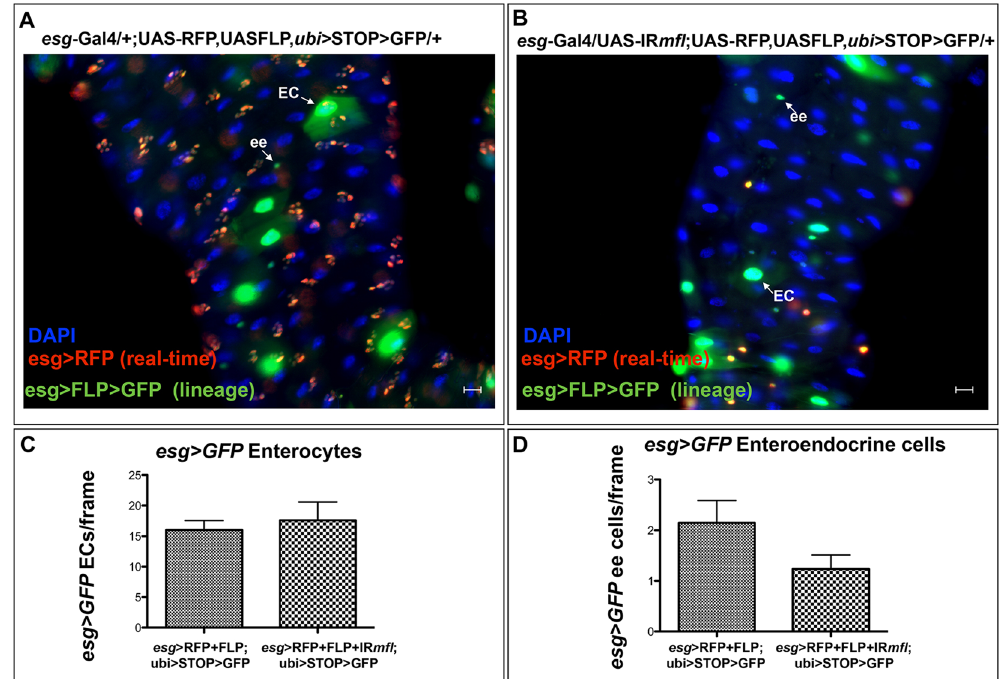
Figure 6. Lineage tracing analysis of midgut esg + cells. Control ( A ) and silenced ( B ) midguts were analyzed in epifluorescence at the third larval stage. DAPI is in blue; GFP in green; esg + cells are marked by RFP in red and appear as clustered into imaginal islands in ( A ) and as dispersed cells in ( B ); white arrows indicate differentiated ECs and ees deriving from esg + precursors. Scale bars: 20 µ m. Histograms reporting the number of GFP + ECs ( C ) and of GFP + ee cells ( D ) deriving from esg + precursors show that both types of differentiated cells did not significantly increase in silenced respect to control midguts (Mann-Whitney